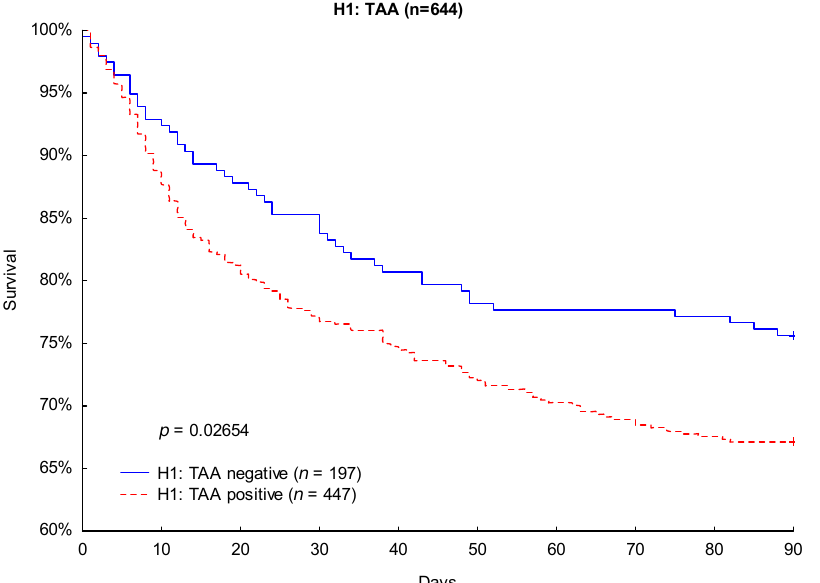
Figure 4. Kaplan–Meier survival analysis (90 days) with regard to the CTLA ‐ 4 haplotype H1: TAA.